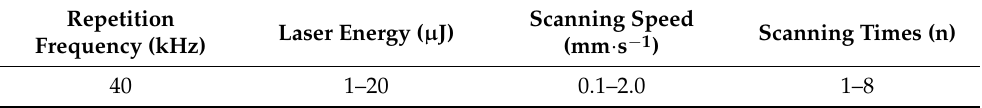
Table 4. The range of the femtosecond laser processing